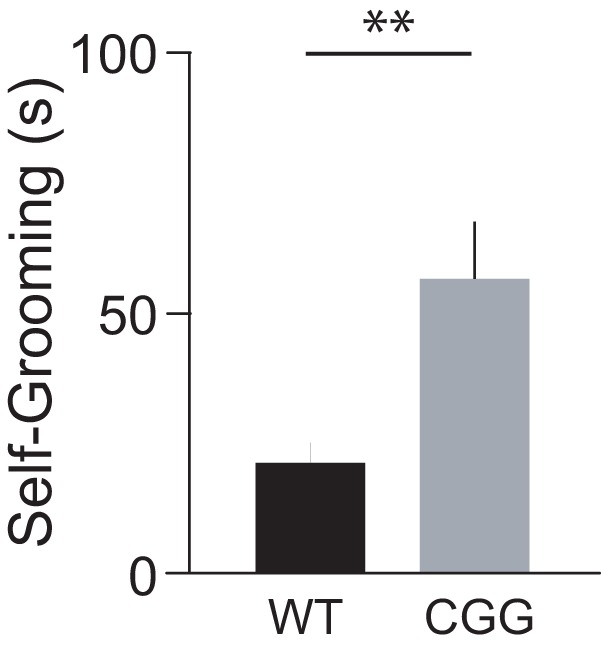
Self-grooming of CGG animals. CGG mice spent significantly more time self-grooming than WT mice (Mann–Whitney test, p = 0.004). n = 13 for each group.